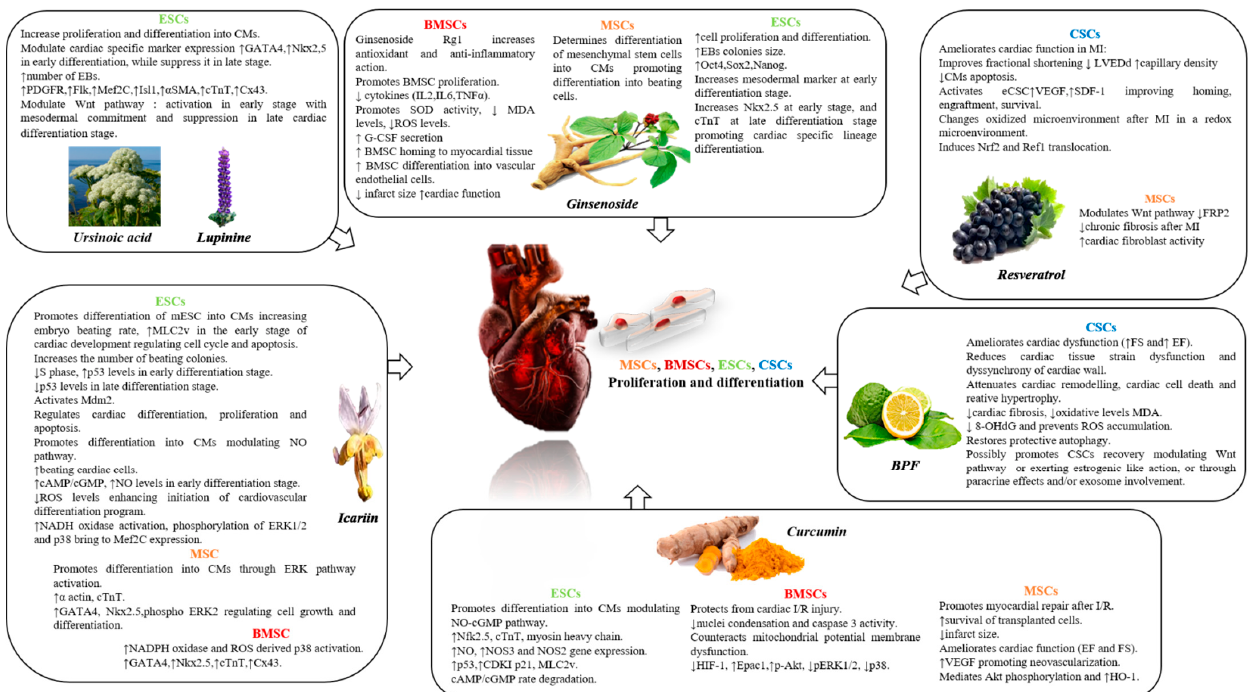
Figure 3. The role of certain natural compounds in stem cell activation. ↑ increase, ↓ decrease. ESCs: embryonic stem cells; CMs: cardiomyocytes; GATA-4: GATA-binding protein 4; Nkx2.5: NK2 transcription factor related locus 5; EBs: embryoid bodies; PDGFR: Platelet-Derived Growth Factor Receptor; Mef2C: Myocyte Enhancer Factor 2c; Isl1: Insulin gene enhancer protein-1; α -SMA: α -Smooth Muscle Actin; cTnI: cardiac Troponin I; Cx43: Connexin 43; BMSCs: bone marrow stem cells; MSCs: mesenchymal stem cells; IL-2: interleukin-2; IL-6: interleukin-6; TNF- α : tumor necrosis factor- α ; SOD: superoxide dismutase; MDA: malondialdehyde; ROS: reactive oxygen species; G-CSF: granulocyte colony-stimulating factor; Oct4: Octamer-binding transcription factor 4; Sox-2: SRY-box transcription factor-2; CSCs: cardiac stem cells; MI: myocardial infarction; LVEDd: left ventricular end diastolic diameter; VEGF: vascular endothelial growth factor; SDF-1: stromal cell- derived factor-1; MLC2v: myosin light chain 2v; Mdm2: E3 ubiquitin-protein ligase; NO: nitric oxide; FS: fractional short- ening; EF: ejection fraction; NOS3: nitric oxide synthase 3; NOS2: nitric oxide synthase 2; CDKI p21: cyclin-dependent kinases inhibitor p21; HIF-1 α : Hypoxia-Inducible Factor-1 α ; I/R: ischemia/reperfusion; HO-1: heme oxigenase-1.